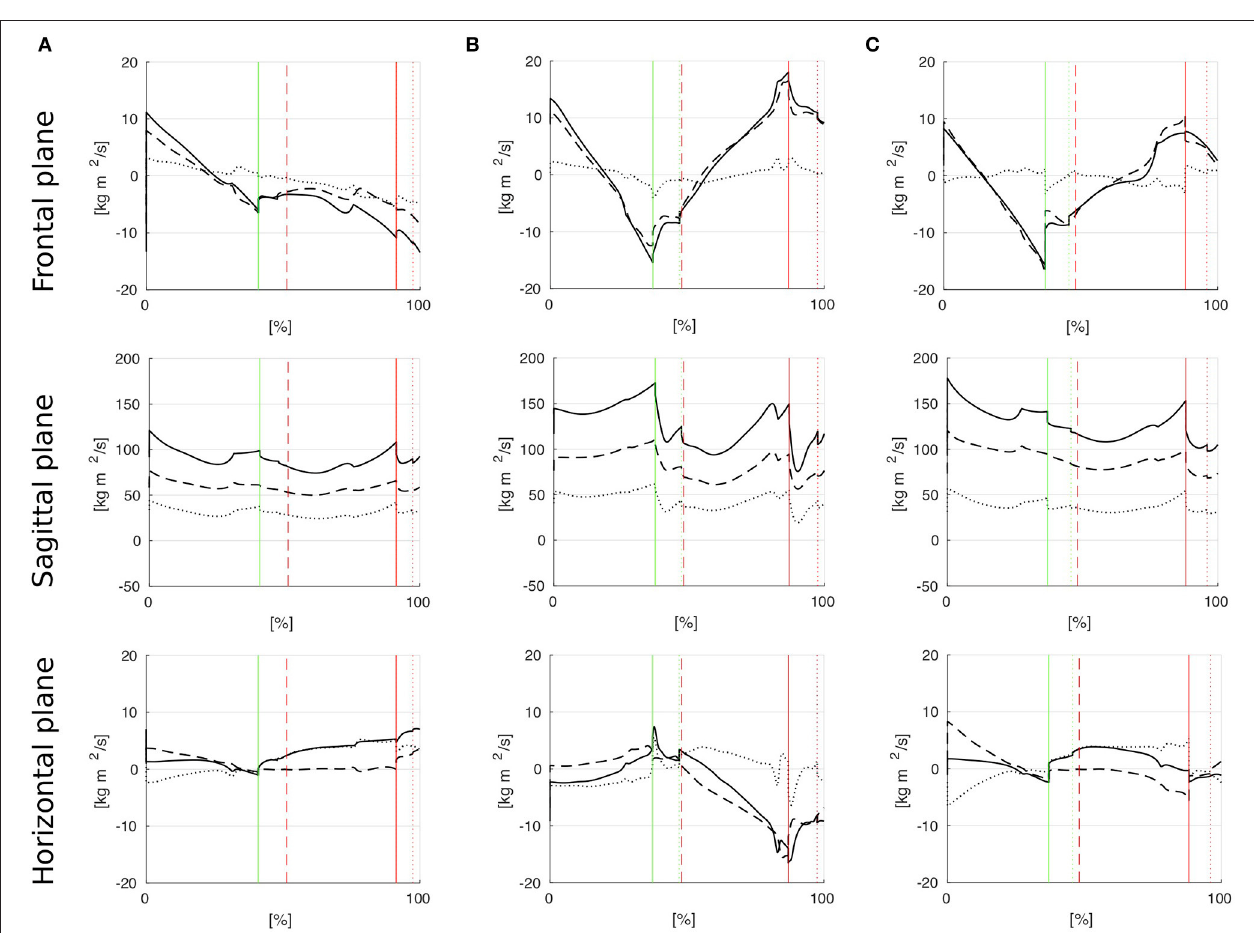
FIGURE 5 | Angular momenta in frontal, sagittal, and horizontal plane for the upper body (dashed), the lower body (dotted) and the full body (solid) motion. Vertical lines indicate the gait events heel strike (solid), toe strike (dotted) and toe off (dashed) for the left (green) and right (red) feet, respectively. (A) Unimpaired female, (B) Unimpaired male, (C) Male with